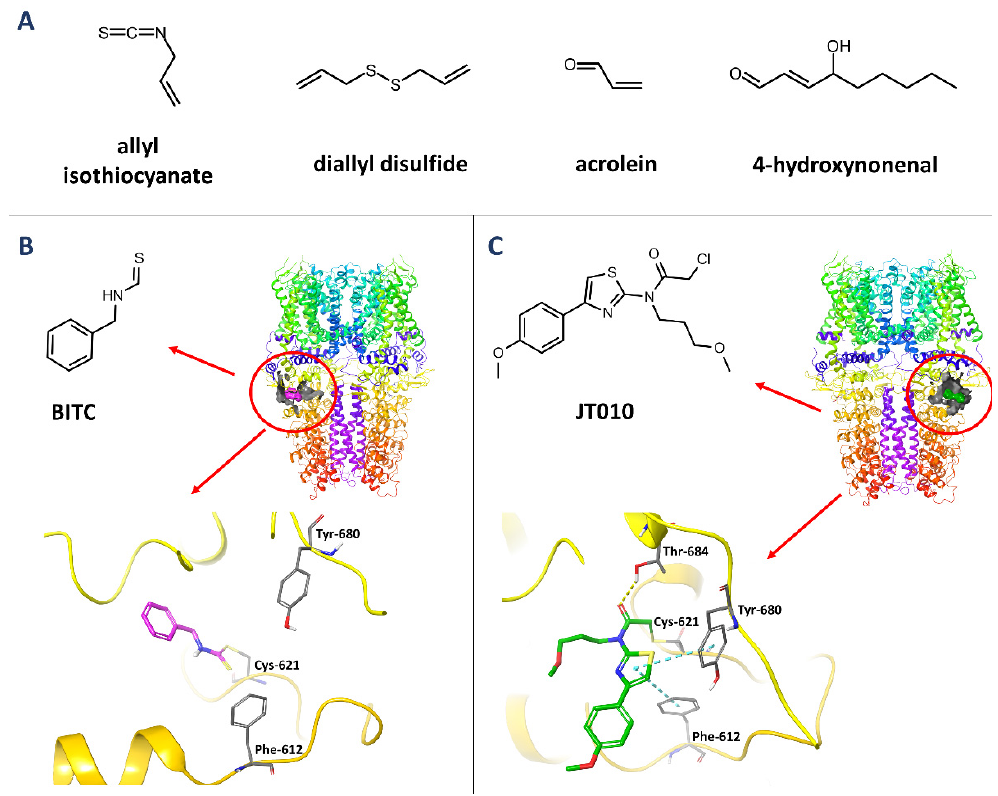
Figure 2. The structures of electrophilic TRPA1 agonists ( A ) and covalent agonists: BITC ( B ) and JT010 ( C ), their binding site location in the TRPA1 structure and their binding mode (yellow—hydrogen bonds, cyan— π - π stacking interactions) based on PDB: 6PQP and 6PQO [9], respectively.